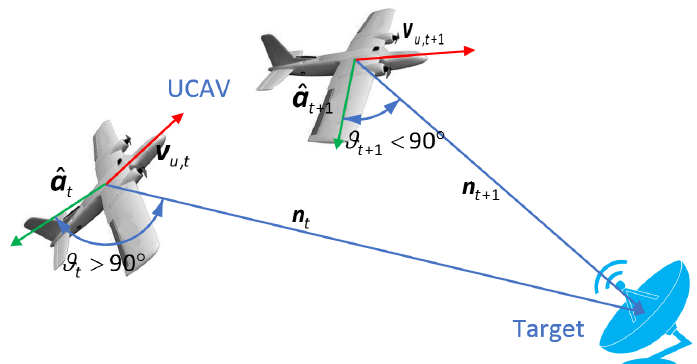
Figure 3. Schematic diagram of the behavior angle of UCAV in